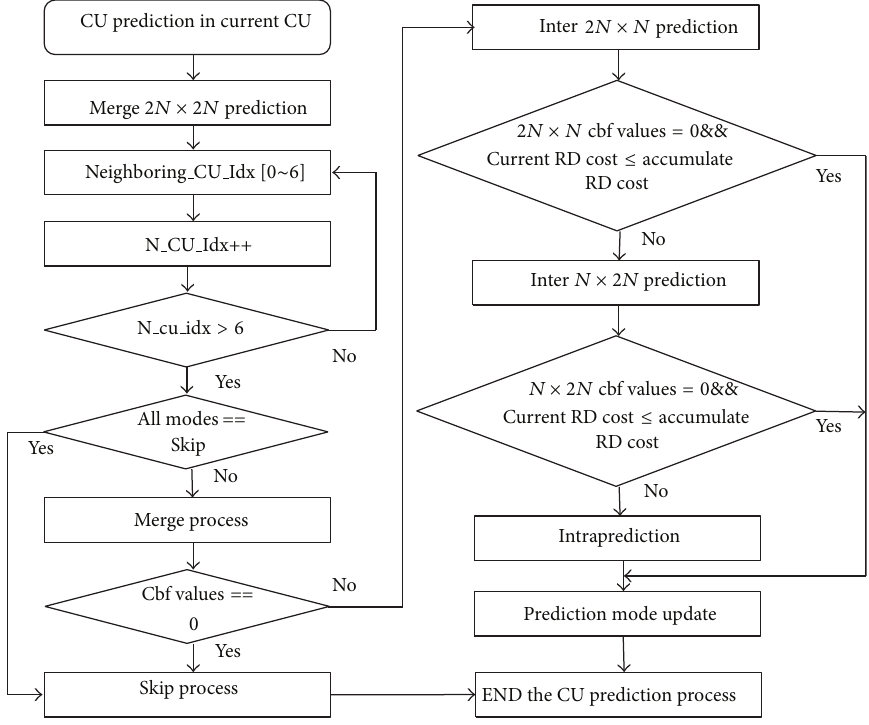
Figure 4: Flowchart for the fast CU detection method.